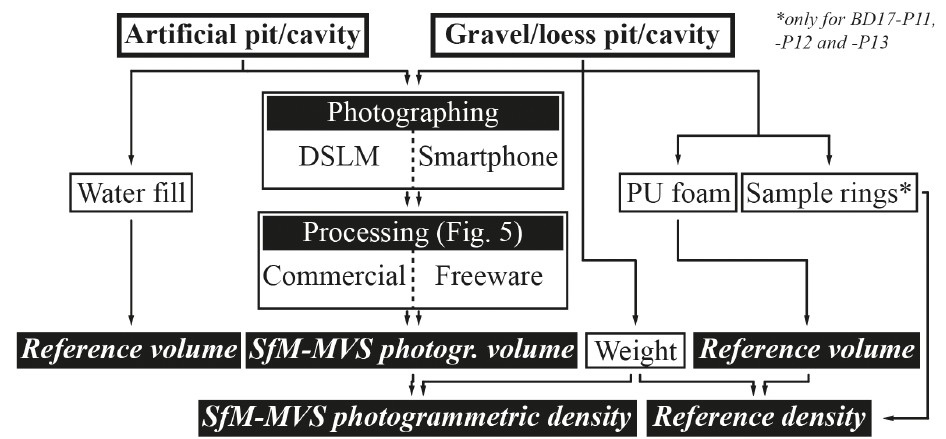
Figure 2. Generalised workflow applied to obtain SfM-MVS photogrammetry-based volumes, reference volumes and field-state soil bulk densities for testing purposes.